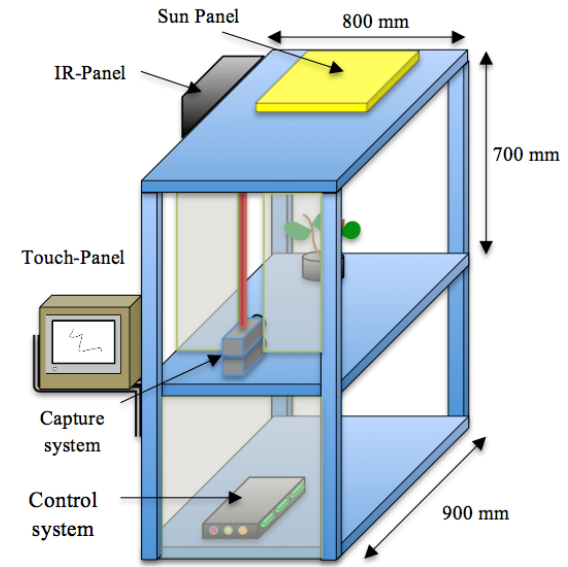
Figure 1. Growth chamber with computer vision